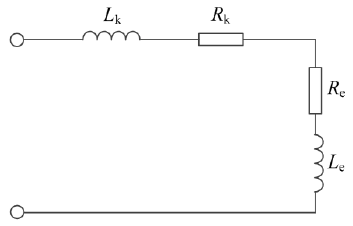
Figure 6. Equivalent model of the electromagnetic unit.